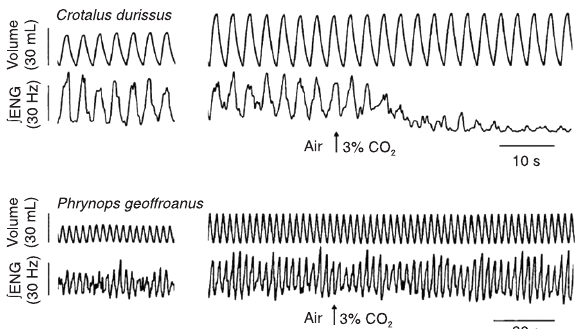
Figure 7. The effects of mechanical inflation of the lungs (left traces) and inhalation of 3% CO 2 (right traces) on integrated af- ferent activity recorded from the whole vagus nerve of the rattle- snake, Crotalus durissus , and the side-necked turtle, Phrynops geoffroanus. The upper trace records are changes in lung volume and the lower trace records are changes in nerve discharge rates (Modified from Ref. 60, with